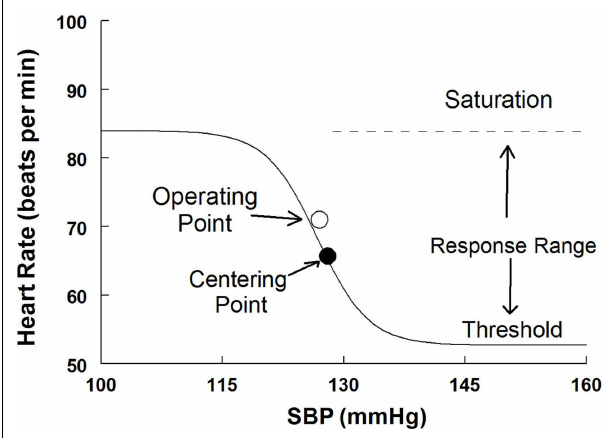
FIGURE 2 |A sigmoid fitted curve using the modified Oxford procedure to generate the HR vs. systolic blood pressure relation. The operating point, centering point, threshold, saturation, and response range are